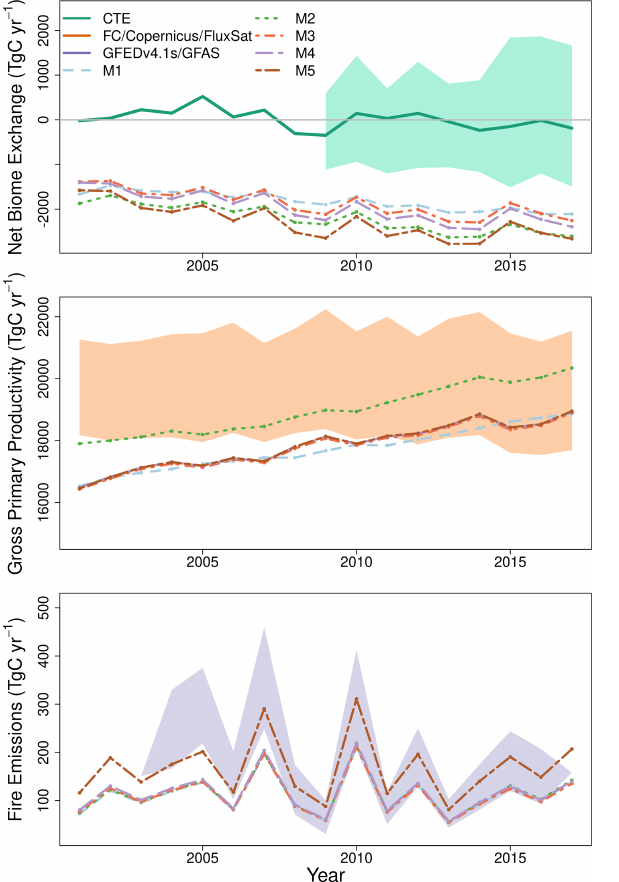
Figure 5. Time series comparison showing the carbon budget for Brazil as estimated by CARDAMOM for each version of DALEC using the pixel-level median estimates. Independent data, where available, are shown as a single solid line. The shaded areas denote the maximum range the independent estimate for CTE (blue), the maximum range between FLUXCOM, Copernicus and FluxSat v2 (orange), and the range between GFEDv4.1s and GFAS fire emis- sions estimates